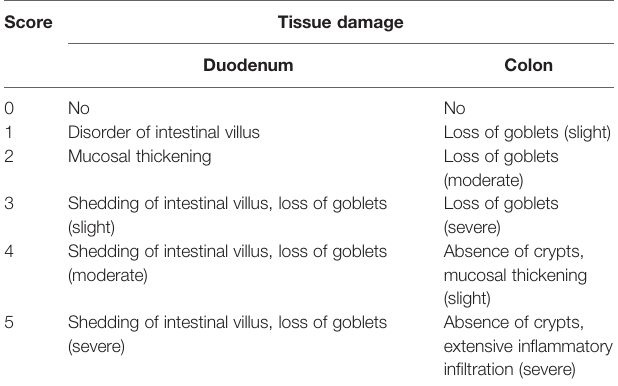
TABLE 2 | Mice intestinal histological scoring